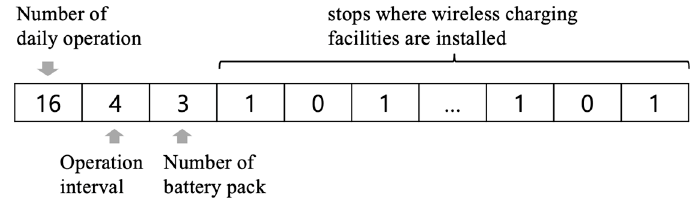
Figure 5. Example of a chromosome.